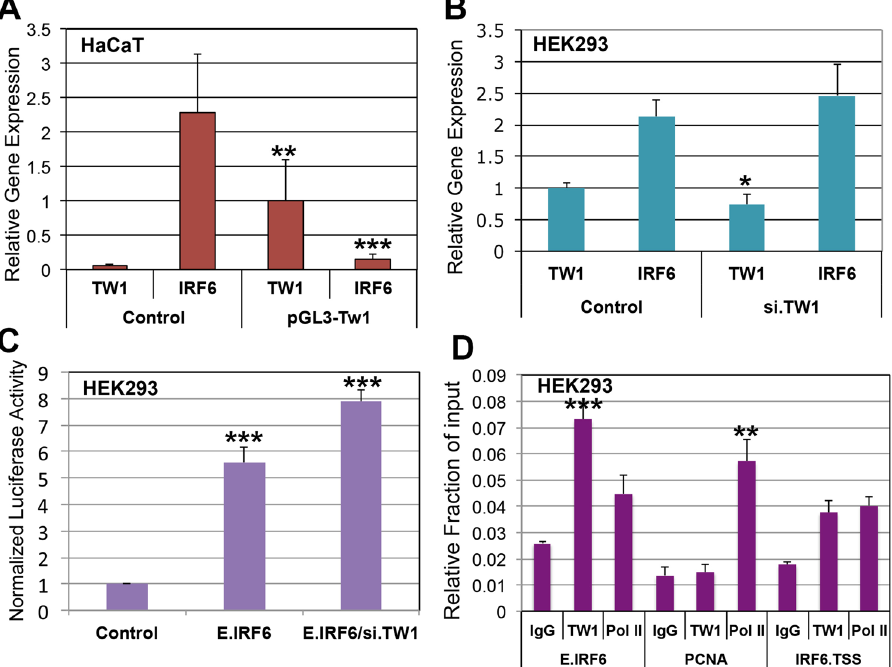
Figure 2. TWIST1 suppresses IRF6 expression in vitro via its enhancer element. RTqPCR data shows that TWIST1 is not expressed in HaCaT keratinocytes, while IRF6 is highly expressed in these cells ( A ). Exogenous overexpression of TWIST1 using pGL3 expression vector remarkably reduced IRF6 expression by 12-fold 48 h post-transfection ( A ). In human embryonic kidney cells (HEK293), TWIST1 is moderately expressed compared to IRF6 that is expressed 2-fold more ( B ). Knockdown of TWIST1 expression with siRNA slightly increased the expression level of IRF6 in HEK293 cells ( B ). However, knockdown of TWIST1 expression significantly increased luciferase activity of a luciferase gene that is under direct control of IRF6 enhancer element ( C ). ChIP-seq data showed that TWIST1 binds to IRF6 enhancer element accompanied by enrichment of RNA PolII protein at the enhancer and promoter element of IRF6 gene, but the enrichment of PolII at the enhancer and promoter regions of IRF6 may indicate an active transcriptional state. However, the amount of PolII at the IRF6 enhancer and promoter compared to IgG was not significant and the enrichment was moderate compared to PolII at PCNA promoter ( D